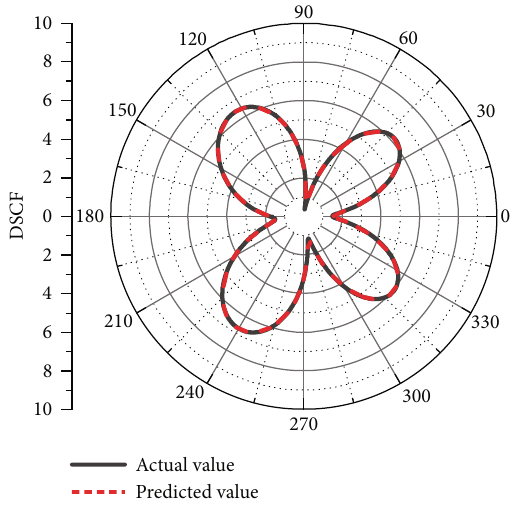
Figure 16: Comparison between actual results and predicted